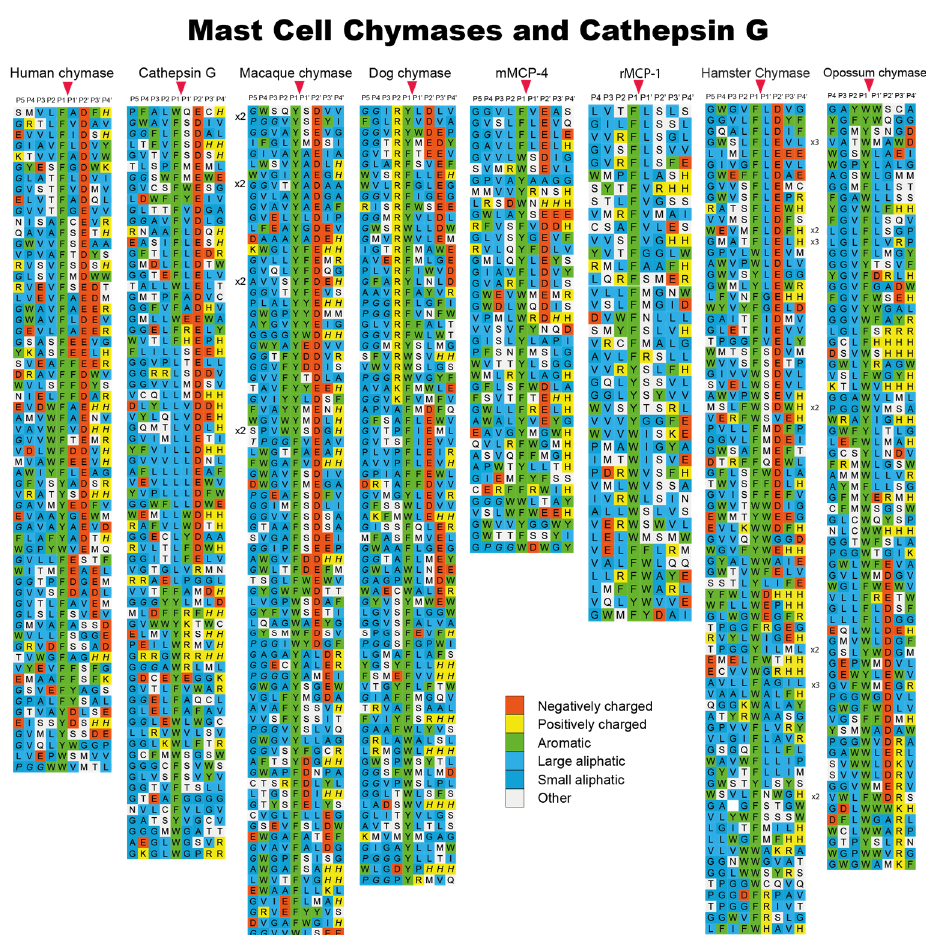
Figure 4. Phage display results for a panel of mammalian connective tissue mast cell chymases and of human cathepsin G. Phage display results for an analysis of the human mast cell chymase, the human cathepsin G, the mast cell chymase of the macaque, the dog chymase, mMCP-4, rMCP-1, hamster mast cell chymase and the opossum mast cell chymase. The amino acids are color coded as shown in the bottom of the figure. The cleavage by the enzyme occur after the P1 residue as marked by red arrow heads. The figure contains data from six earlier publications [11,24,32,39,41,42].